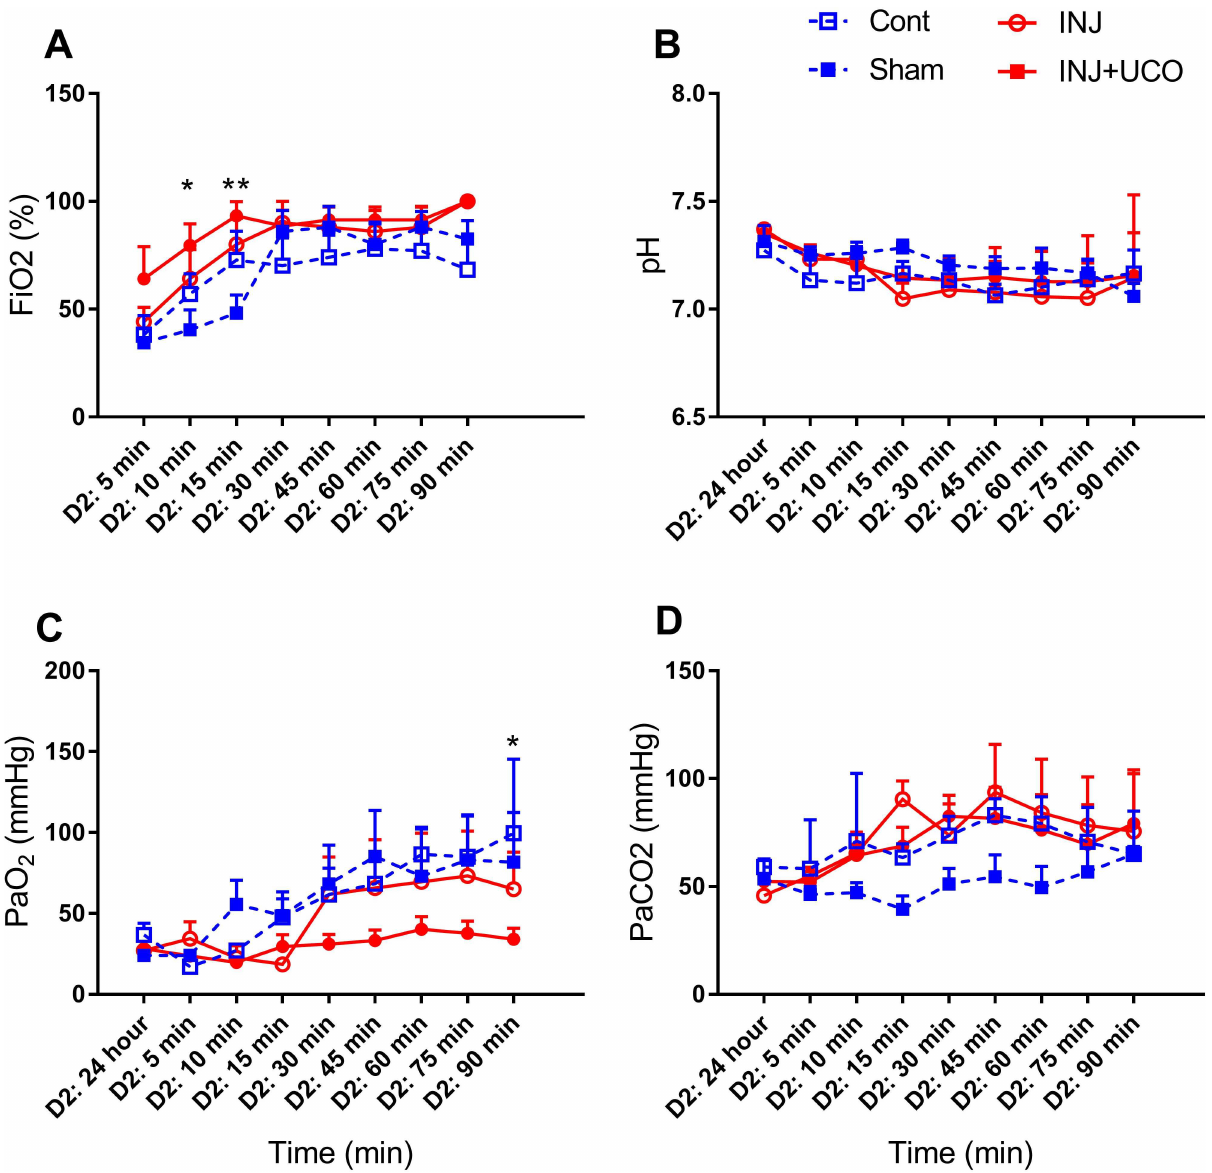
Fig 1. Physiological parameters. (A) Fraction of inspiredoxygen (FiO 2 ) in the unoperatedcontrol (Cont; blue open squares n = 6), sham surgery (Sham; blueclosed squaresn = 5), injuriousventilation(INJ; red open circles n = 5), and INJ + umbilicalcord occlusion (INJ+UCO; red closed circles n = 7) groups. (B) pH. (C) Partial pressureof arterial oxygen (PaO 2 ) and (D) carbondioxide(PaCO 2 ). * P < 0.01, ** P < 0.001 vs INJ+UCO.